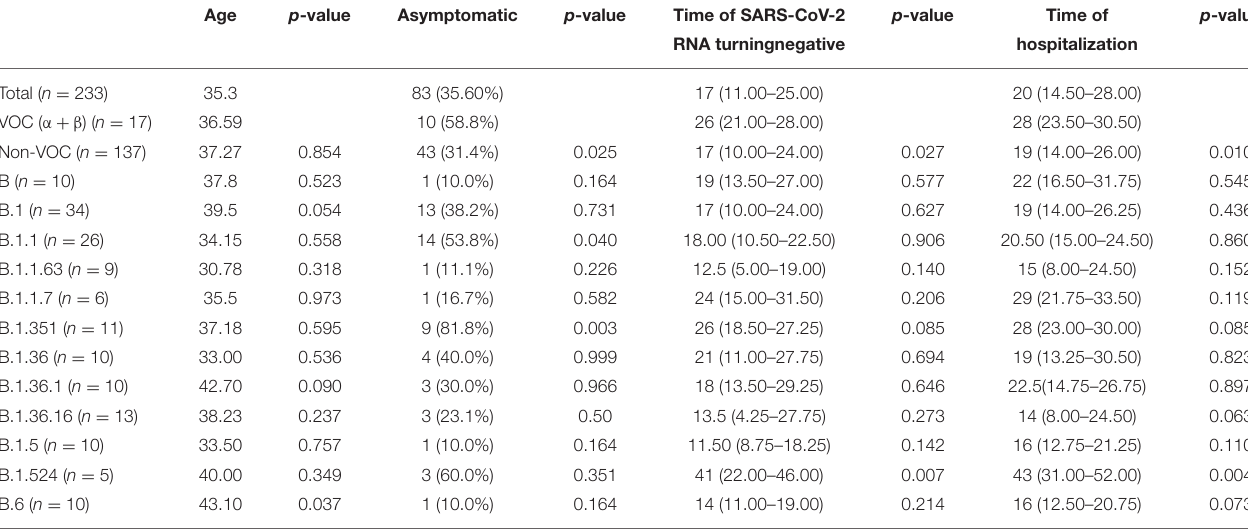
TABLE 3 | Comparison of asymptomatic and time of SARS-CoV-2 RNA turning negative between total and variants infected patients ( n ≥ 5). Age p -value Asymptomatic p -value Time of SARS-CoV-2 p -value Time of p -value RNA turningnegative